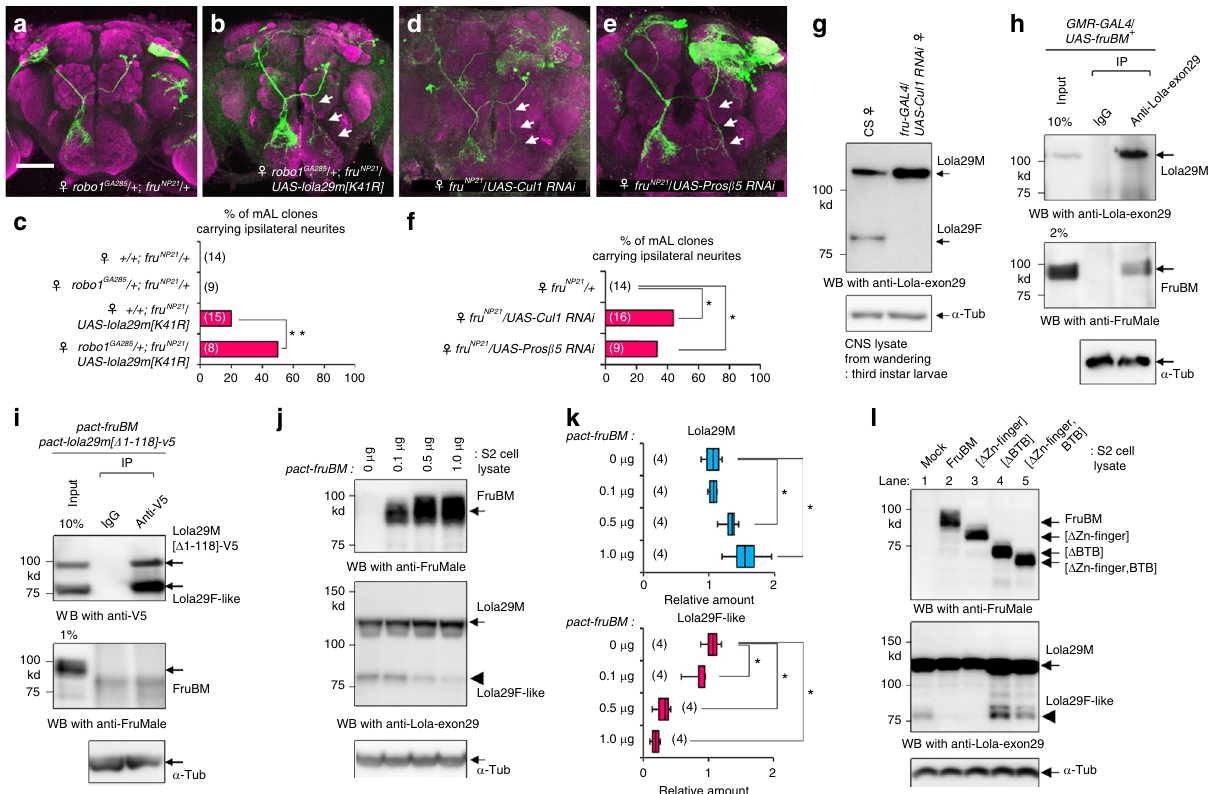
Fig. 6 FruBM protects Lola29M from its ubiquitin-proteasome-mediated truncation. a – c mAL neuroblast clones in robo1 GA285 / + females without ( a ) or with ( b ) Lola29M[K41R] overexpression and quantitative comparisons of the number of clones carrying the male-speci fi c neurite among the genotypes indicated ( c ). ** P < 0.01 by the Fisher ’ s exact probability test. d – f Knockdown of Cul1 ( d ) or Proteasome subunit β 5 ( e ) in females results in the formation of the ipsilateral neurite. Representative neuroblast clones with the ipsilateral neurite ( d , e ) that is otherwise absent from a female neuron. Scale bar: 50 µ m. f Comparisons of the percentage of mAL neuroblast clones that carried ipsilateral neurites between females without and with Cul1 or Pros β 5 knockdown. * P < 0.05 by the Fisher ’ s exact probability test. g Western blotting with anti-Lola-exon 29 of larval CNS extracts with or without Cul1 knockdown. h – l FruBM protects Lola29M from N-terminal truncation. h Overexpressed FruBM is coprecipitated with endogenous Lola29M. Anti-Lola-exon29 was used for immunoprecipitation and anti-FruMale for detection on western blotting. i – l Lola29M-FruBM interactions depend on the BTB domain of each. The antibody that recognizes the C-terminal V5 tag of Lola29M-V5 (anti-V5) precipitated N-terminally deleted Lola29M-V5 (Lola29M[ Δ 1-118]-V5) but not intact FruBM ( i ) in S2 lysates. j The abundance of Lola29F (middle panel) is inversely proportional to the amount of FruBM (upper panel) and also to that of Lola29M (middle panel) in S2 cells. The amount of fruBM -expressing plasmid ( pact-fruBM ) used for transfection is indicated above each lane. α -Tubulin ( α - Tub) served as a loading control (lower panel). k Relative abundance of Lola29M (upper panel) and Lola29F-like (lower panel) in the presence of different amounts of FruBM (indicated at the left of the bars). * P < 0.05 by the Kruskal – Wallis analysis of variance followed by Steel ’ s nonparametric multiple comparisons. l Deleting the Fru BTB domain resulted in Lola29F production ( Δ BTB: lane 4; Δ Zn- fi nger, BTB: lane 5), whereas deleting the Zn- fi nger motif ( Δ Zn- fi nger: lane 3) did not. Western blots of overexpressed proteins probed with anti-FruMale (upper panel), anti-Lola-exon 29 (middle panel) and anti- α -Tub (lower panel). The box plot shows median and 10th, 25th, 75th, and 90th